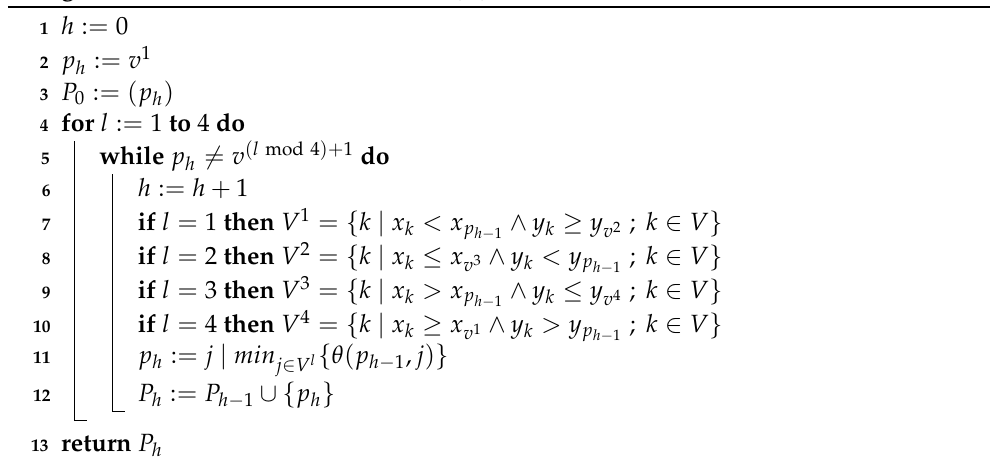
Algorithm 1: GIRDING − POLYGON ( V ).